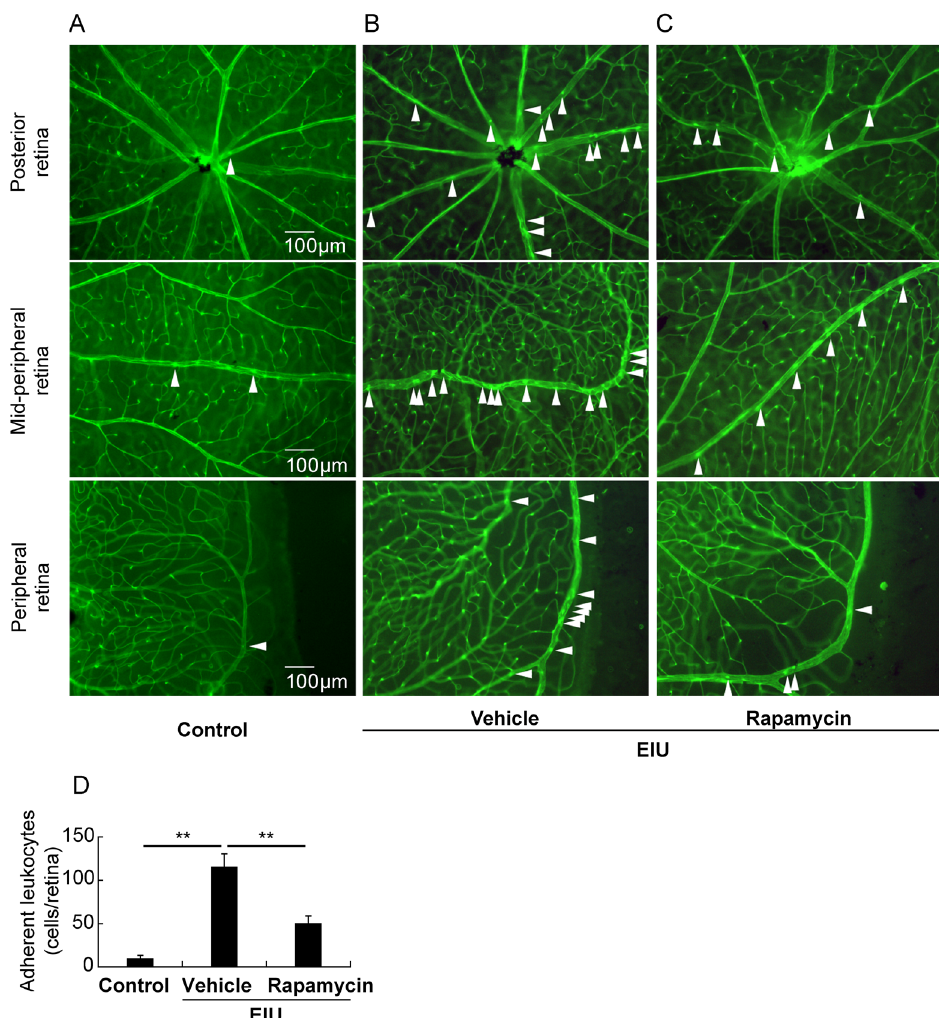
Fig 4. Rapamycin suppressed leukocyte adhesion in the retina during inflammation. Analysis of leukocyte adhesion in flatmount retinas showed that adherent leukocytes were minimally observed in the vehicle-treated control mice (A), and were substantially increased in the vehicle-treated EIU mice (B). However, rapamycin attenuated the number of adherent leukocytes (C). Quantification of adherent retinal leukocytes (D). Scale bar, 100 μ m; n = 5. ** p <